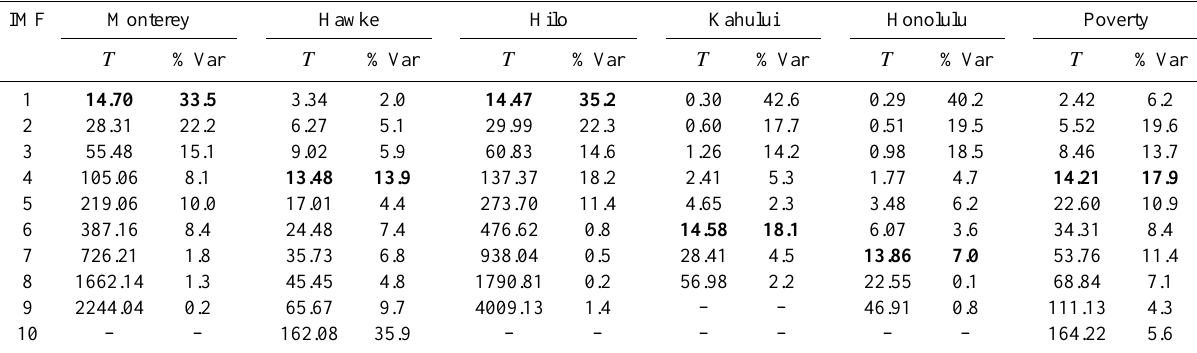
Figure 5. Shelf-resonance power spectral density (PSD) amplitudes (black) with low-frequency IMFs (metamodes) in red. The large ampli- tude in Poverty Bay is a result of the 27 February 2010 Chile 8.8 M earthquake and tsunami. Table 5. Mean period in days ( T ) of Hilbert instantaneous frequencies and percent variance of shelf-resonance power spectral density IMFs (metamodes). Modes with mean periods close to fortnightly tidal constituents with periods of 14.76 ( M sf ) and 13.66 days ( M f ) are highlighted in bold.